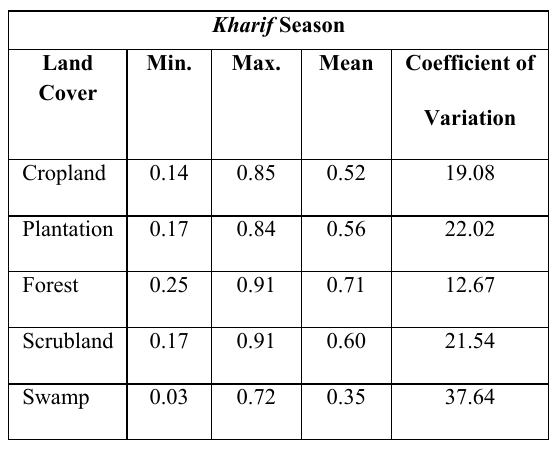
Table 2. Zonal Averaged NDVI of Land Covers in Tamil